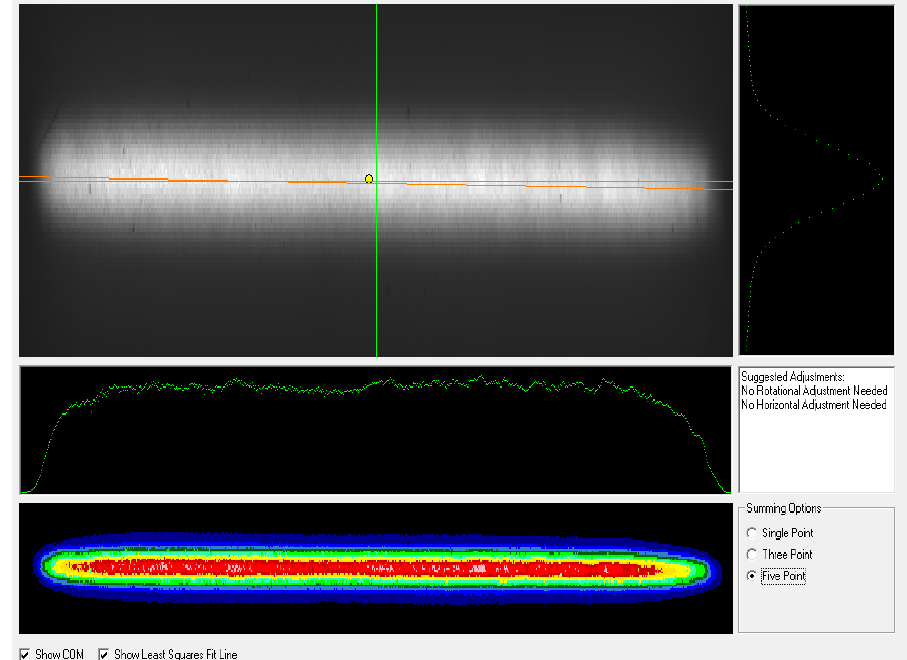
Figure 9. The bottom figure shows a false color image of the illumination profile for a single laser pulse using the Powell lens. The five-point average across the center of the profile that is displayed immediately above the false color image demonstrates the uniformity of the profile.